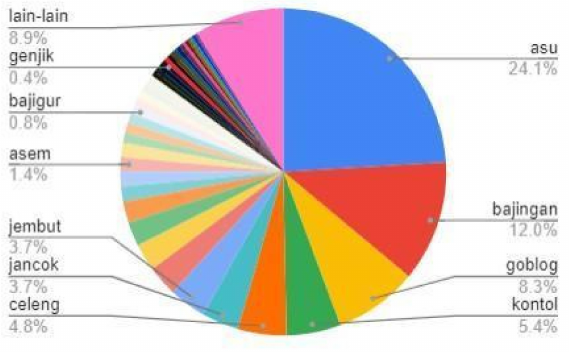
Fig 4. Badwords in